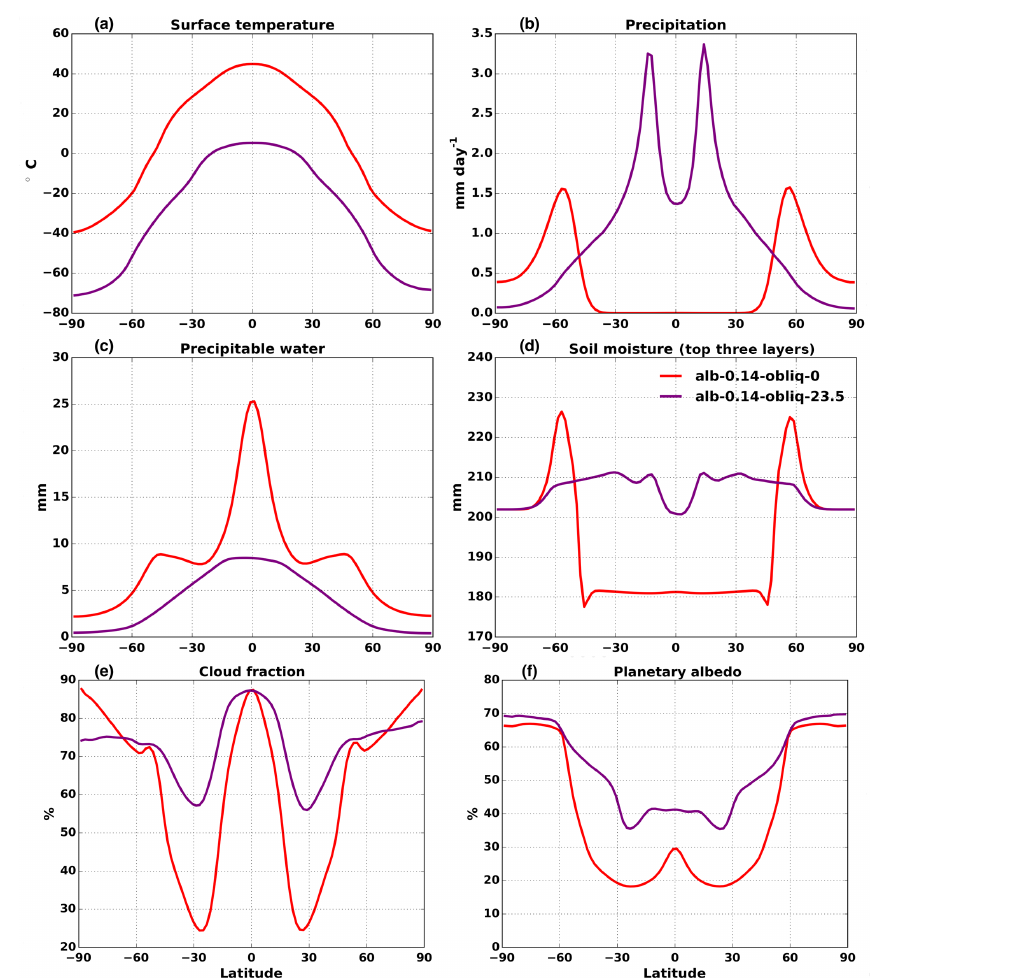
Figure 9. Annual mean meridional profiles as in Fig. 2. The red lines represent the HD state as in Fig. 2 (Z14 simulation in Table 1 with an obliquity of 0 ◦ ). The purple lines correspond to the simulation with same initial conditions as in the HD state in Fig. 2 but with an obliquity of 23.5 ◦ (S14 simulation in Table